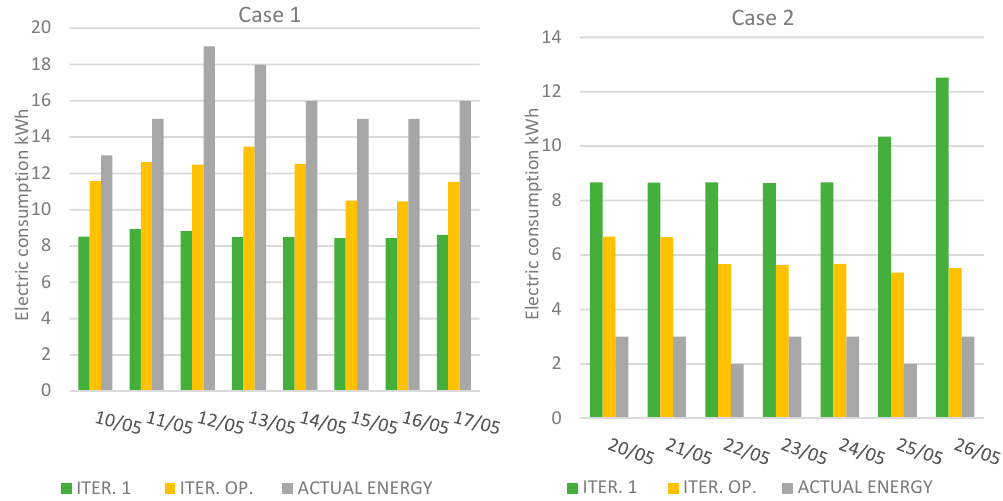
Figure 7. Electric consumption comparison in three levels: iteration 1, optimized iteration and actual energy reading